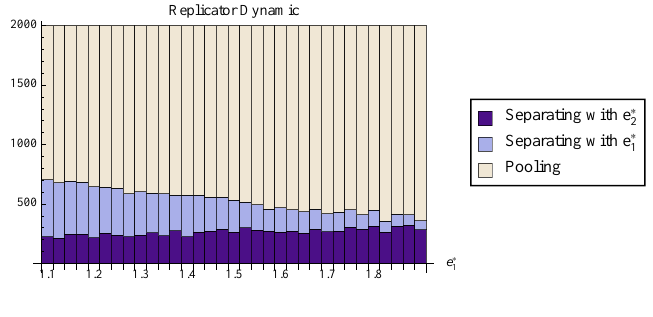
= 1 . 9 and p = . 5 H 2